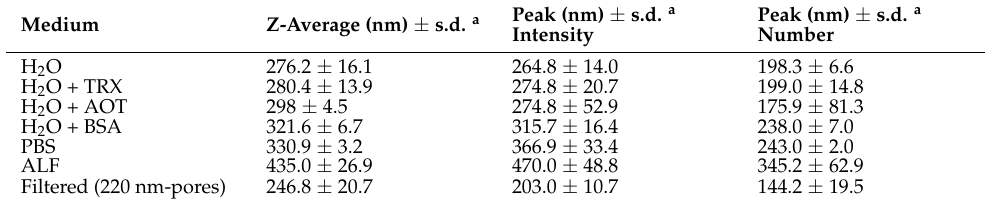
Table 3. Particle size distribution of nanoquartz (gQ-n3) dispersed in biologically relevant media measured by